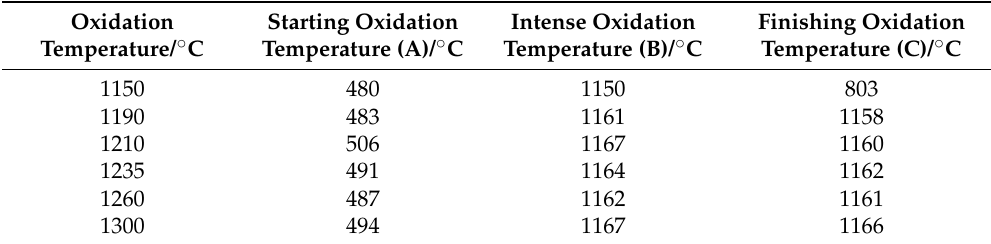
Table 2. Transition temperatures of the oxidation reaction.